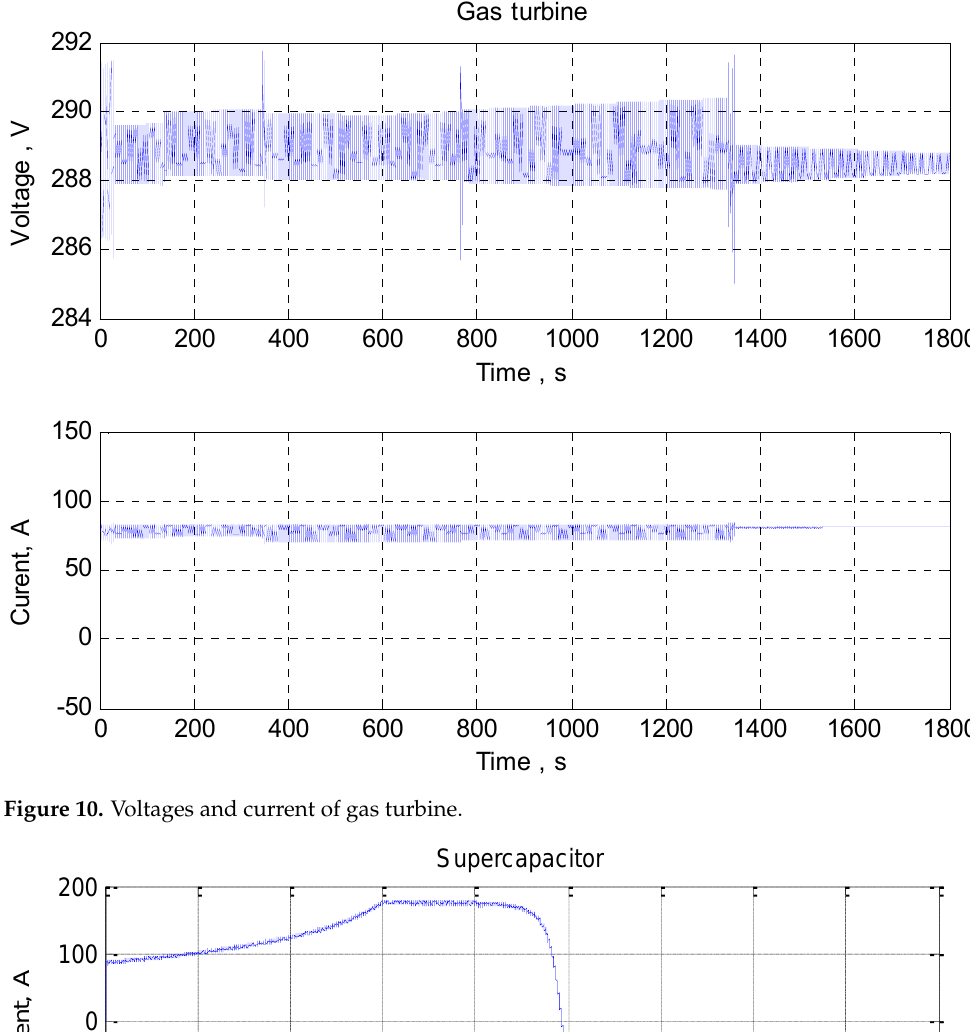
Figure 10. Voltages and current of gas turbine.